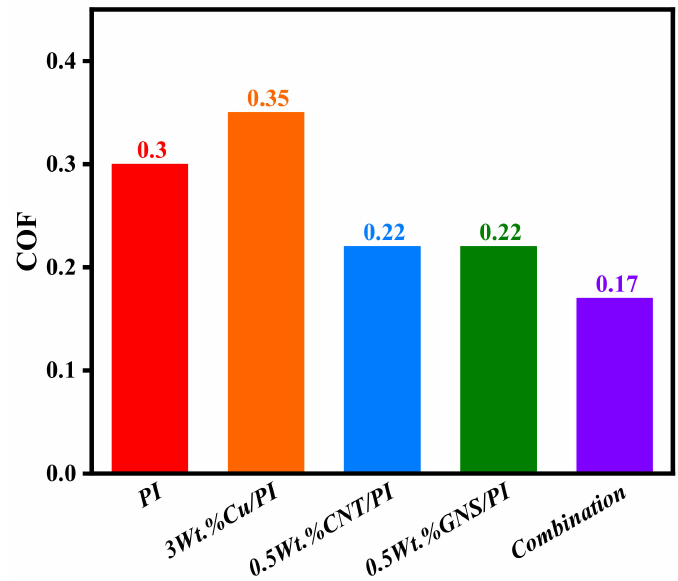
Figure 9. Friction coefficient of friction